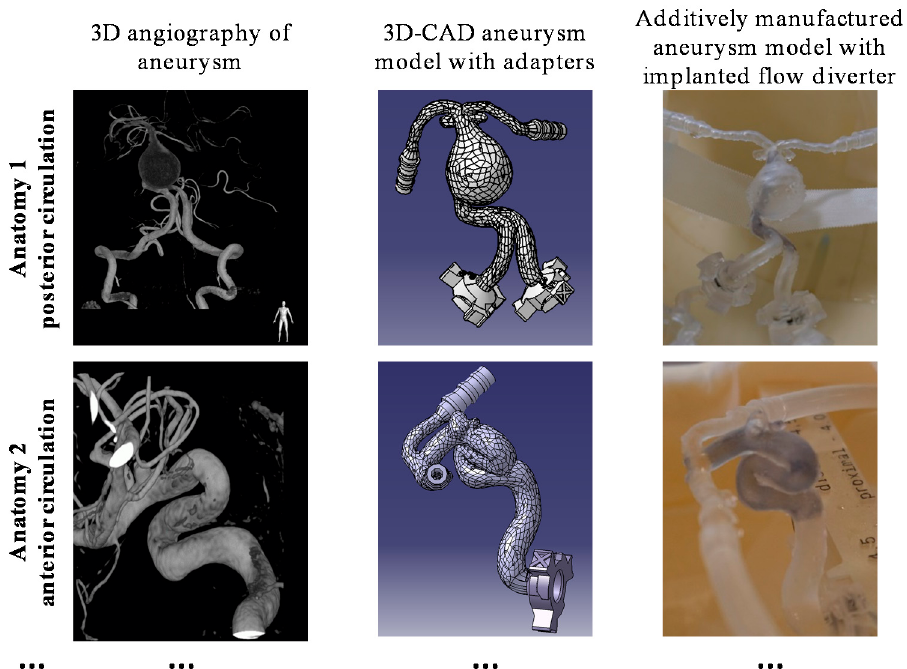
Figure 10. Using additively manufactured aneurysm models developed based on angiographic 3D images with different anatomical characteristics to implant personalized flow diverter variants in order to analyze the impact of specifically designed product characteristics on overall product performance.